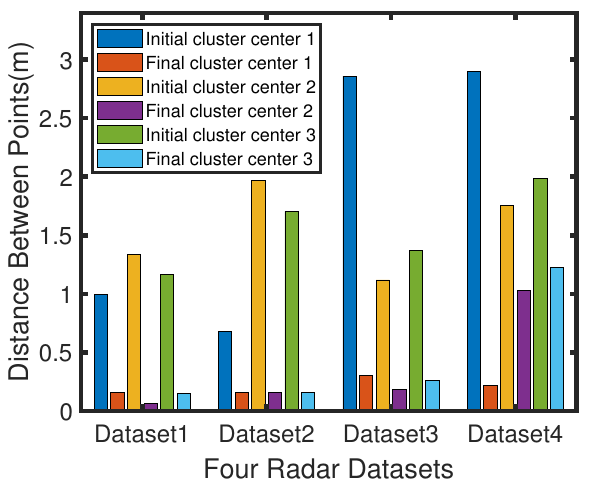
Figure 10. Adaptive ellipse distance density peak fuzzy (AEDDPF) algorithm initial cluster center point distance and final cluster center distance histogram comparison